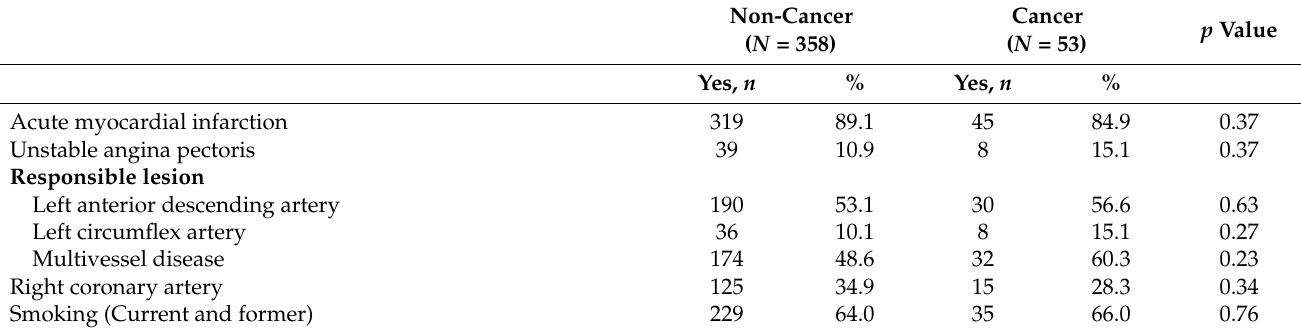
Table 2. Comorbidities and medicine of acute myocardial infarction patients with and without